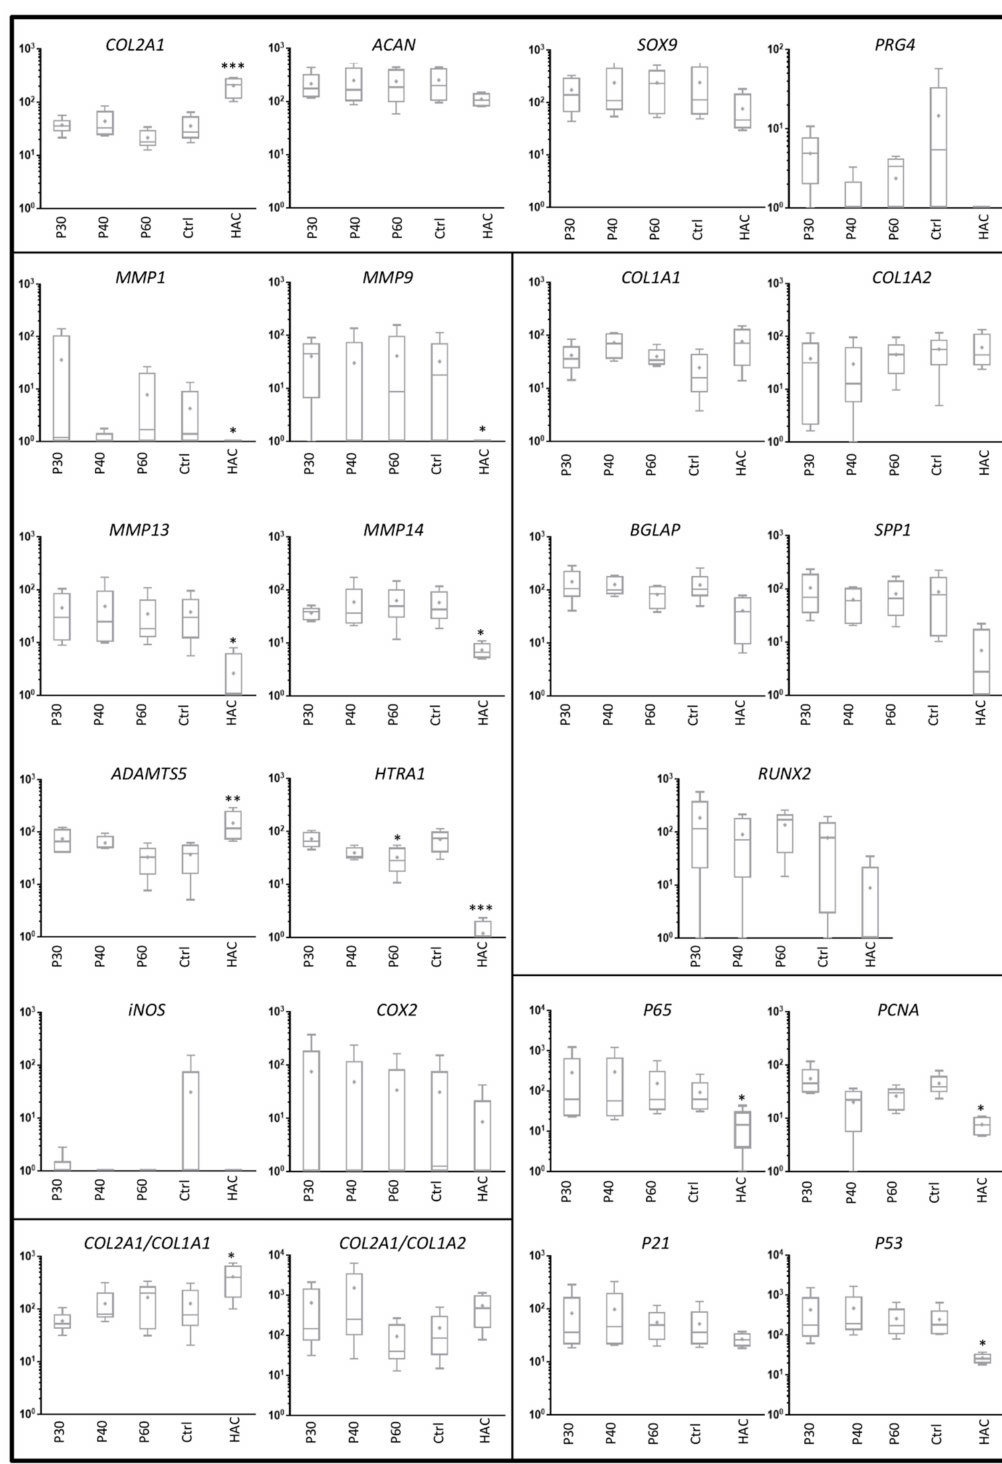
Figure 7. Effect of high concentrations of Promerim ® 30, 40 and 60 on gene expression profile in human articular chondro- cytes. Human articular chondrocytes were grown in type I/III collagen sponges at (P2) for 7 days in hypoxia in the absence (Ctrl: control) or presence of 100 µ g/mL Promerim ® 30, 40 or 60 (P30, P40, P60). Results are summarized in box plots ( n = 5) showing the mean (cross) and the median (line) of relative mRNA expression estimated using RT-qPCR and normalized to the β -ACTIN and PPIA reference genes. The COL2A1 : COL1A1 and COL2A1 : COL1A2 ratios are given. HAC: mRNA obtained from human articular chondrocytes at P0 were used as controls. Statistical analyses were performed using the two-way ANOVA followed by Dunnett’s multiple comparison post-test (* p < 0.05; ** p < 0.01; *** p < 0.001) compared with the control